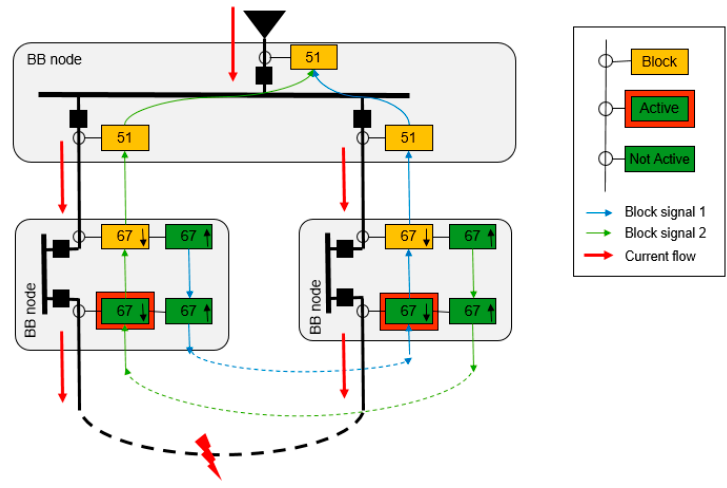
Figure 4. Ring main system based in automatic circuit breakers.